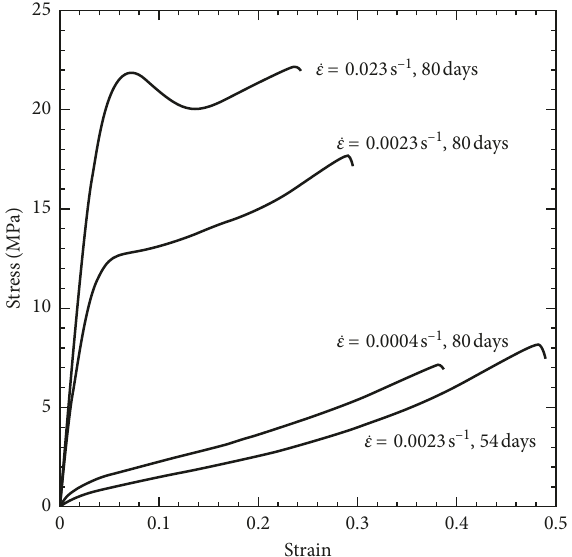
Figure 2: Effect of strain rate _ ε and the age of the specimens on the mechanical behavior of neat PU. The specimens were 1mm thick.